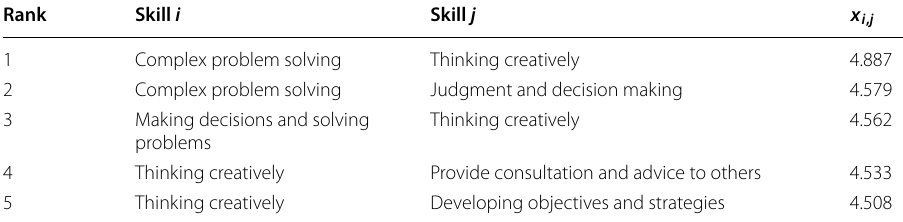
Table 1 Five highest skill-pair interdependence values ( x i , j ) Rank Skill